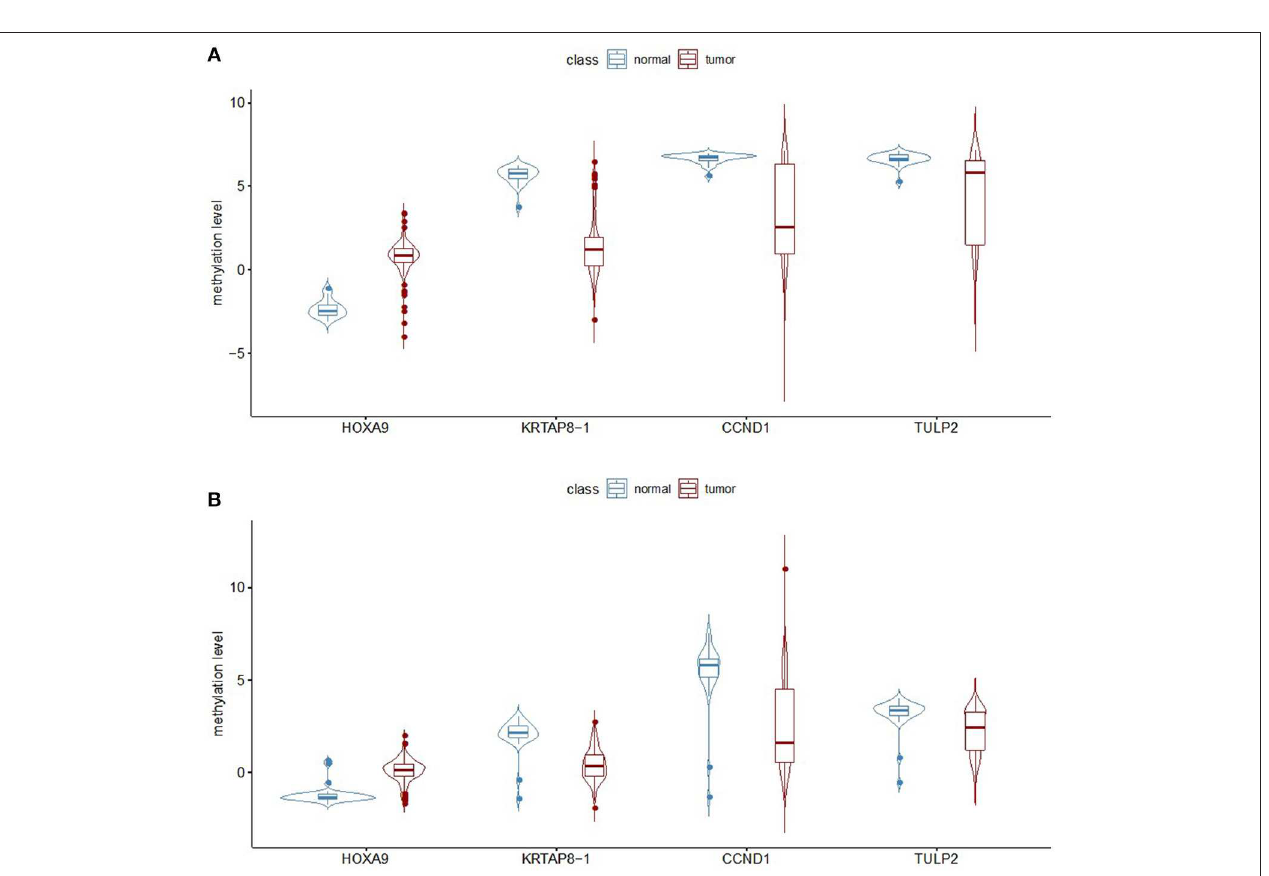
simultaneously informative methylation marker set. The random forest machine learning model, which shows superior performance in the tasks of binary classification, was applied in